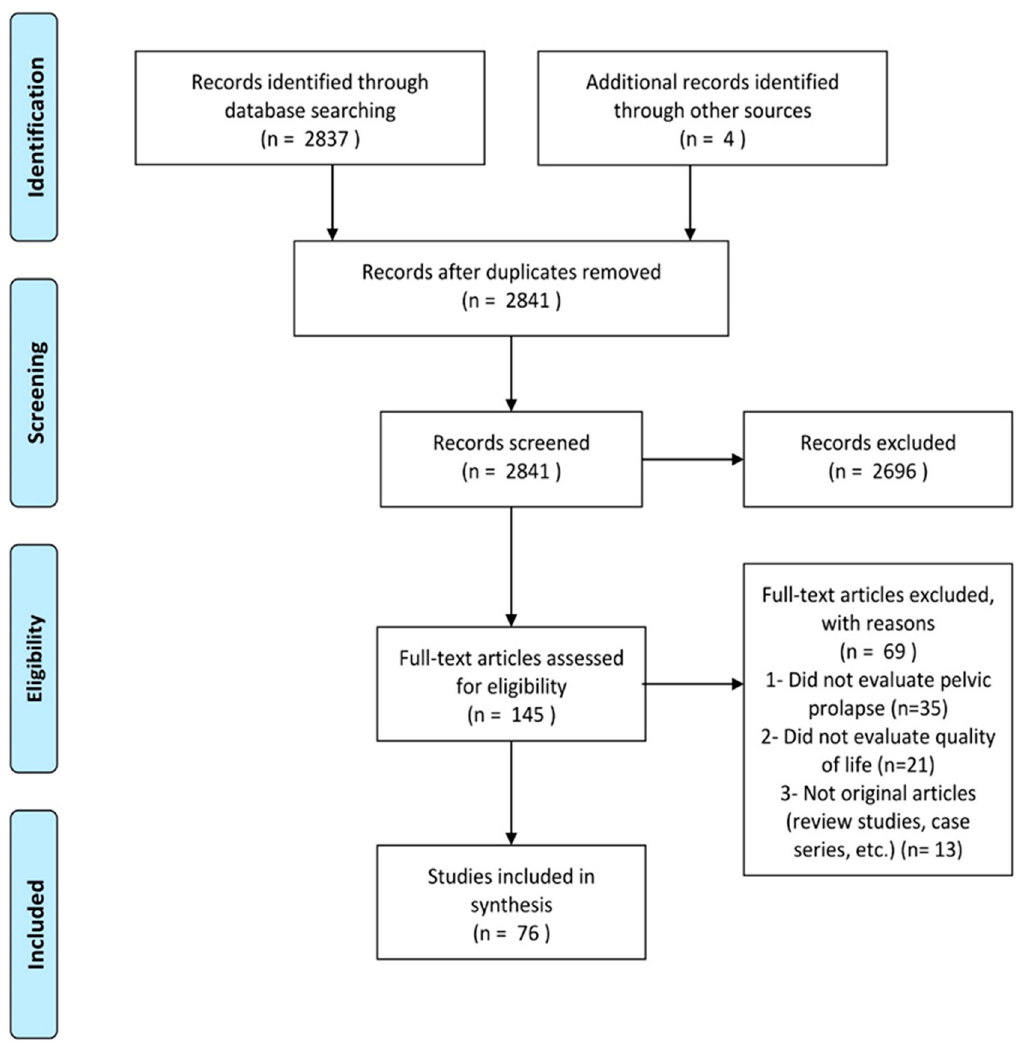
Figure 1. Flow diagram of the recruiting studies according to PRISMA.